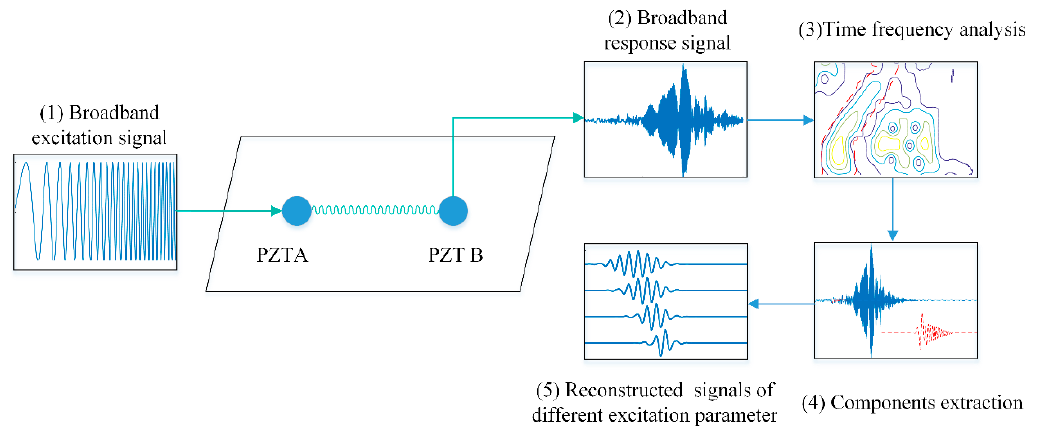
Figure 2. Schematic diagram of the proposed efficient time reversal method (ETRM).